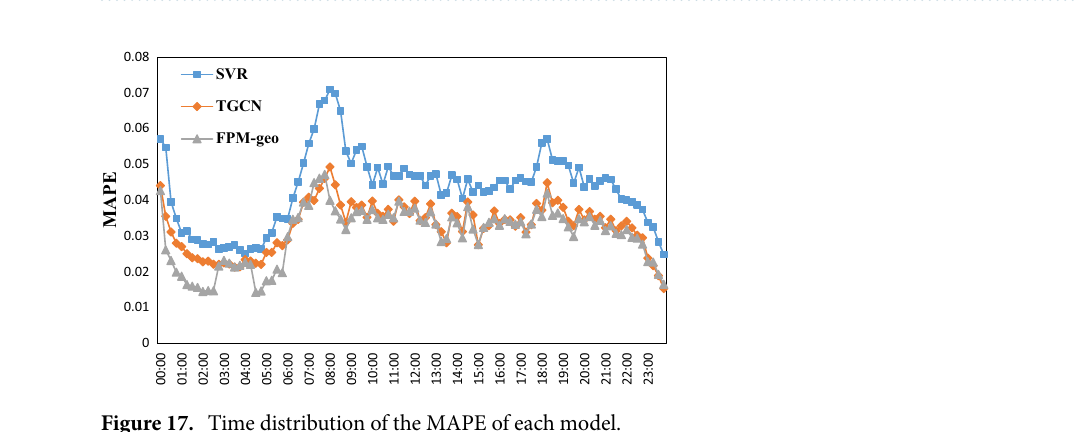
Figure 17. Time distribution of the MAPE of each model.